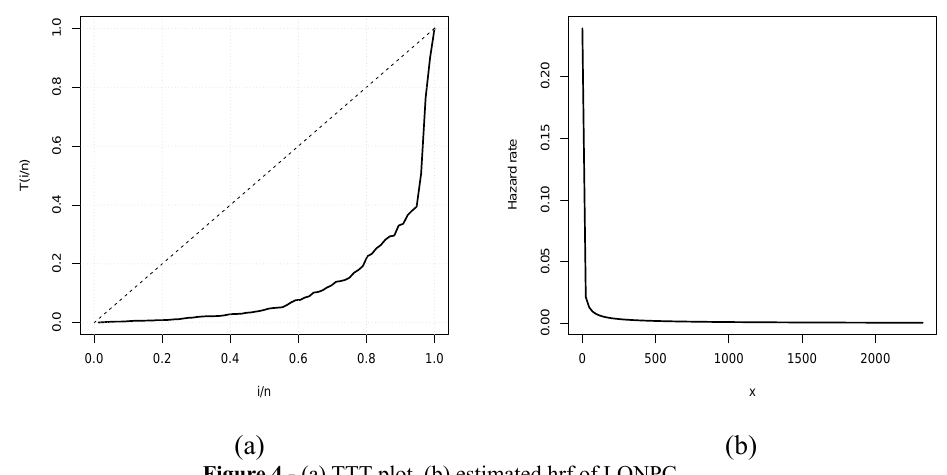
Figure 4 - (a) TTT plot, (b) estimated hrf of